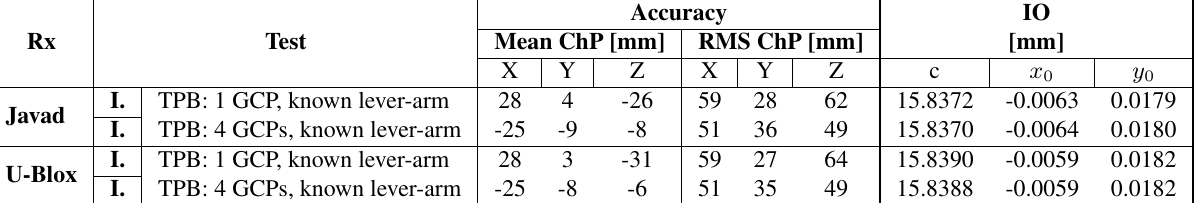
Table 5. Mapping accuracy at 22 ChPs, with 1 or 4 GCPs, and with relative aerial position control.